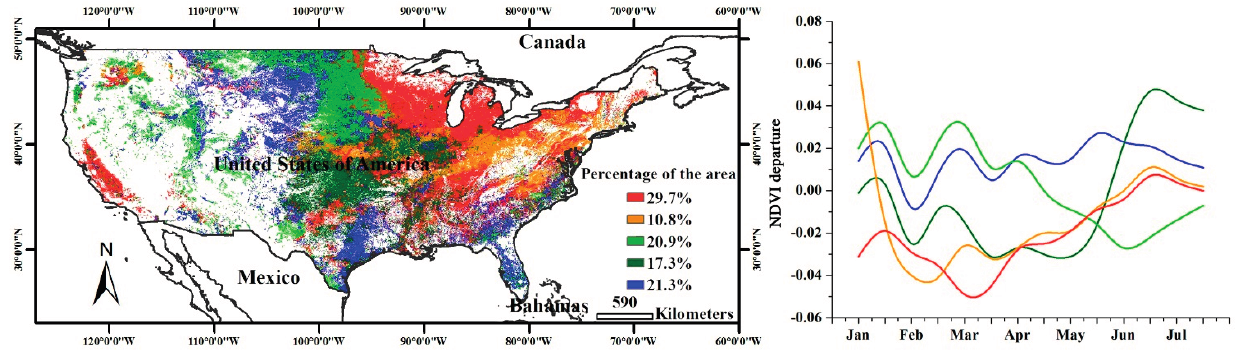
Figure 13. ( a ) The Spatial distribution of NDVI departure cluster during January and July 2014 in the United States; ( b ) The NDVI departure profiles associated with ( a ). The horizontal line marks “0 departure”, i.e. , average